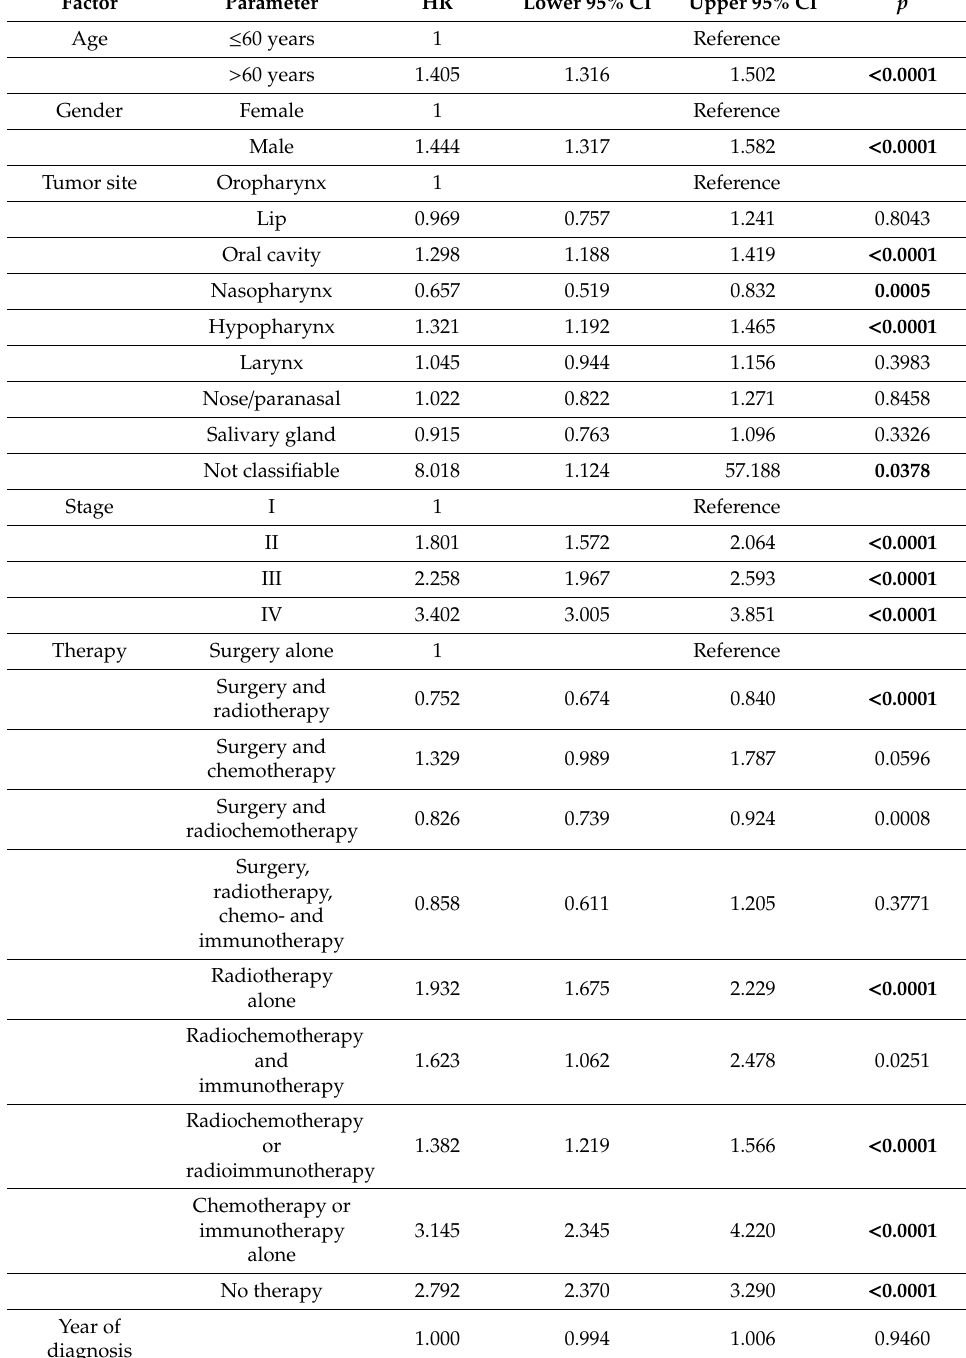
Table 2. Multivariable Cox regression of risk factors for head and neck cancer overall survival including the year of